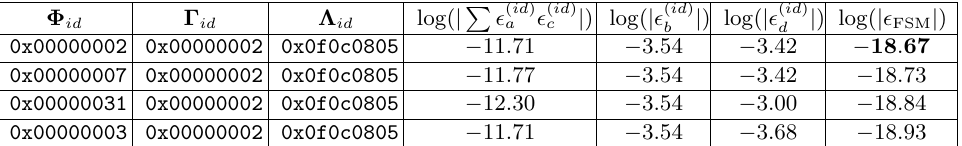
Table 1: The partial linear mask tuples ( Φ id , Γ id , Λ id ) of ( Φ , Γ , Λ ) for the bitwise linear approximations of the FSM of SNOW-V σ 0